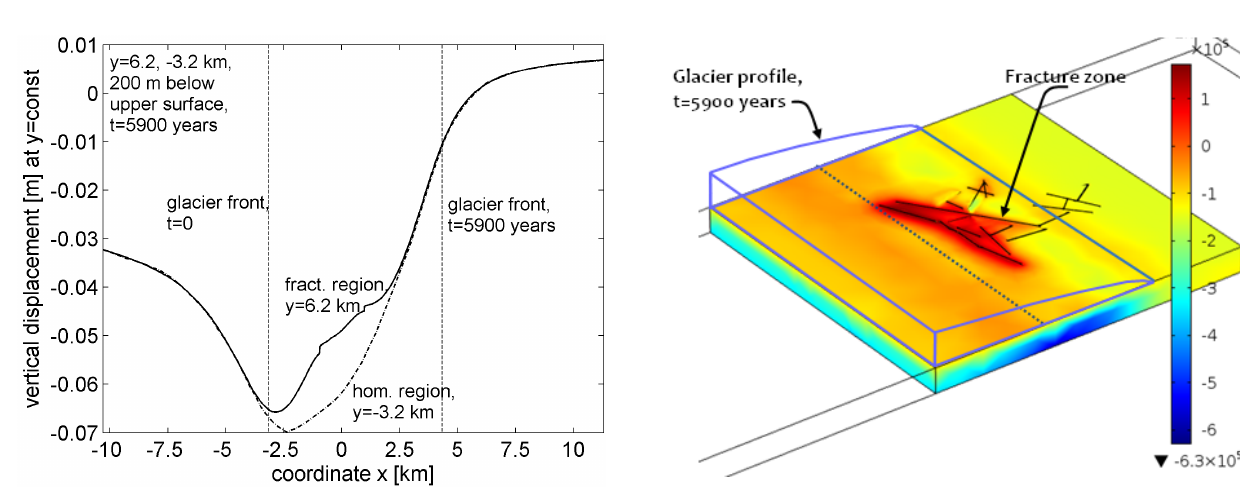
Figure 13. Variation of the vertical displacement [m] in the rock mass with fractures in the cross sections y = 6200 and − 3200m corresponding to the fractured and homogeneous regions respec- tively and at a depth of 200m, at time 5900 years.